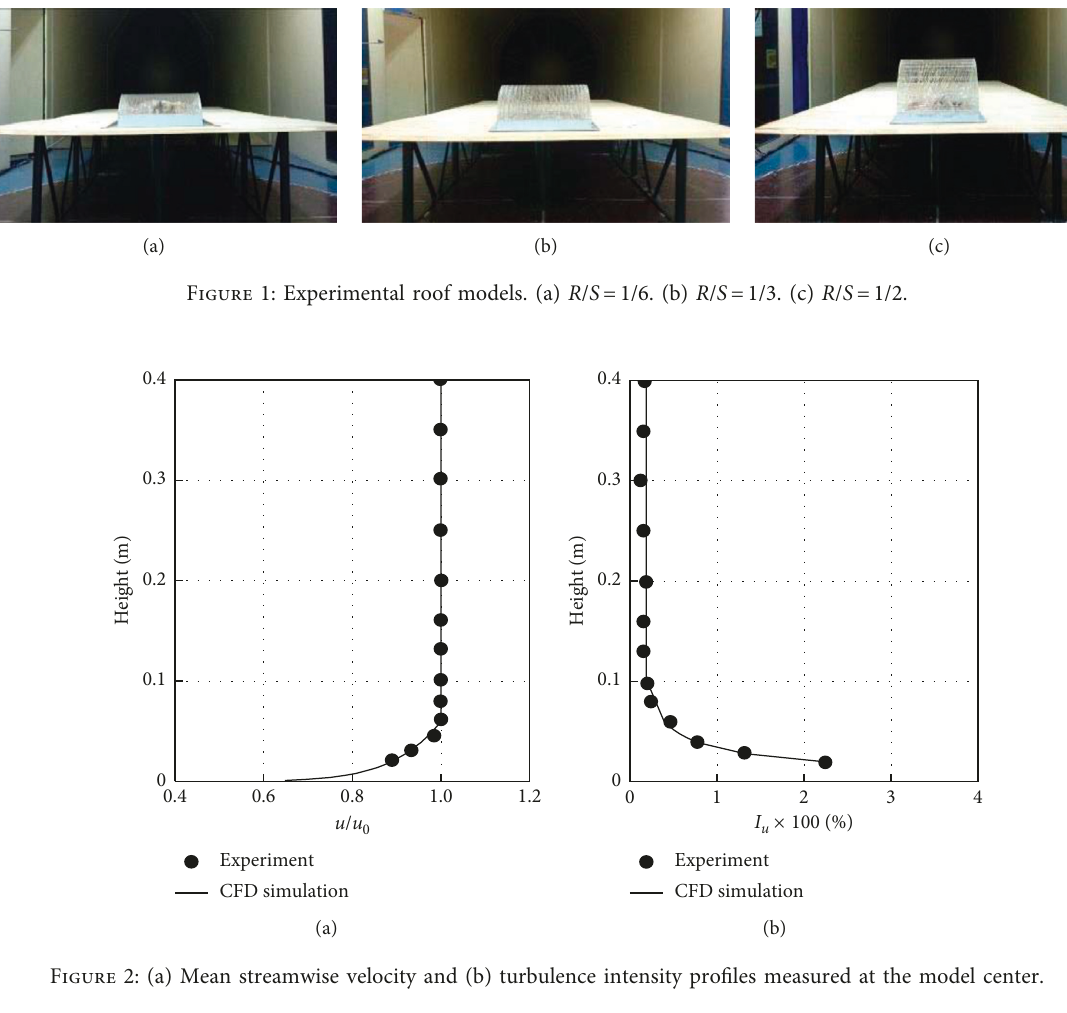
Lift coefficient, C l